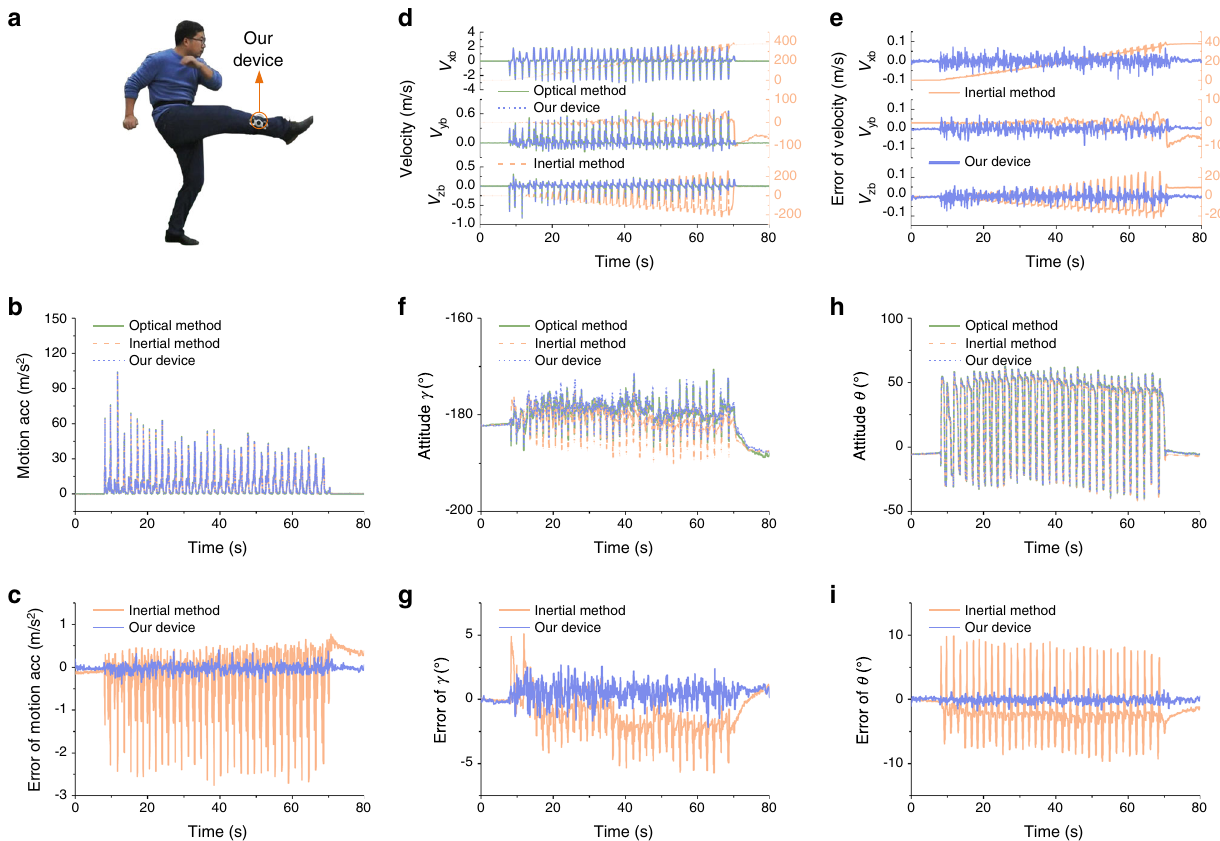
Fig. 5 Kicking motion capture results of shank wearing a device. a The subject wears a device on his shank and conducts kicking activity. b – c The magnitude of motion acceleration measured by our device and inertial method, respectively ( b ), and the corresponding errors ( c ). High dynamic motion with motion acceleration more than 100 m/s 2 is observed. d – e The tri-axis motion velocity measured by our device and inertial method, respectively ( d ), and the corresponding errors ( e ). f – i The attitude estimation results of roll angle γ ( f ) and pitch angle θ ( h ), respectively, and the corresponding attitude errors by our device and inertial method, respectively ( g and i ). Motion capture results of optical VICON system are used as reference